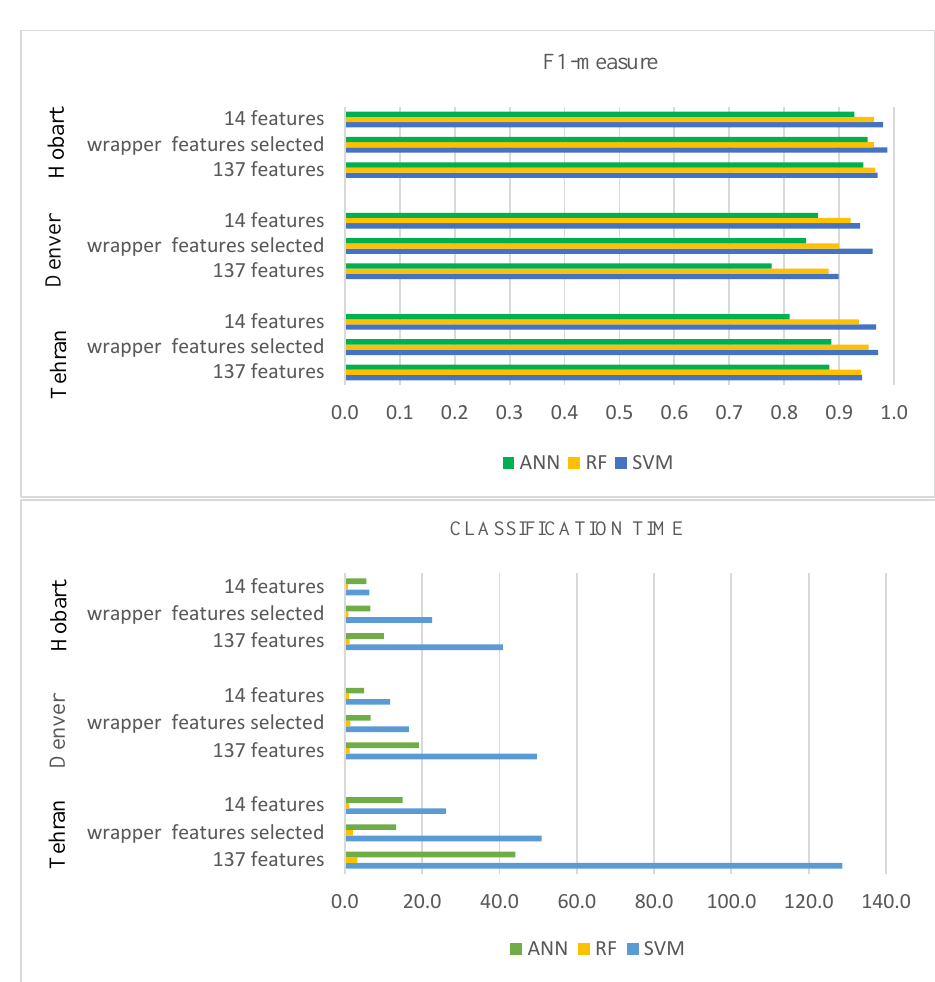
Figure 6. Comparison of the classification accuracy and time (minutes) based on input dataset variation by the best output of each classifier in each image and feature set.